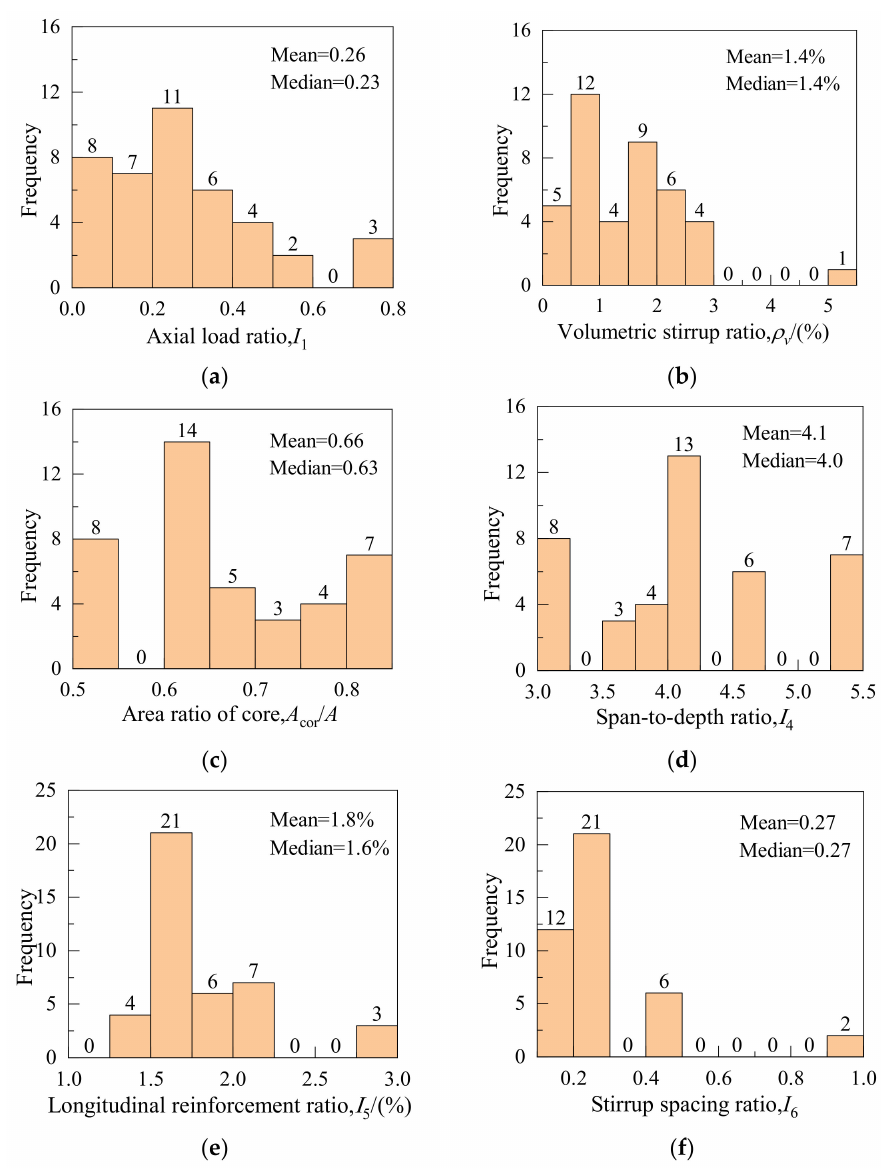
Figure 10. The frequency distribution of the structural parameters. ( a ) The axial load ratio I 1 . ( b ) The volumetric stirrup ratio I 2 . ( c ) The ratio of confined concrete area to section area I 3 . ( d ) The span-to- depth ratio I 4 . ( e ) The longitudinal reinforcement ratio I 5 . ( f ) The stirrup spacing to section height ratio I 6